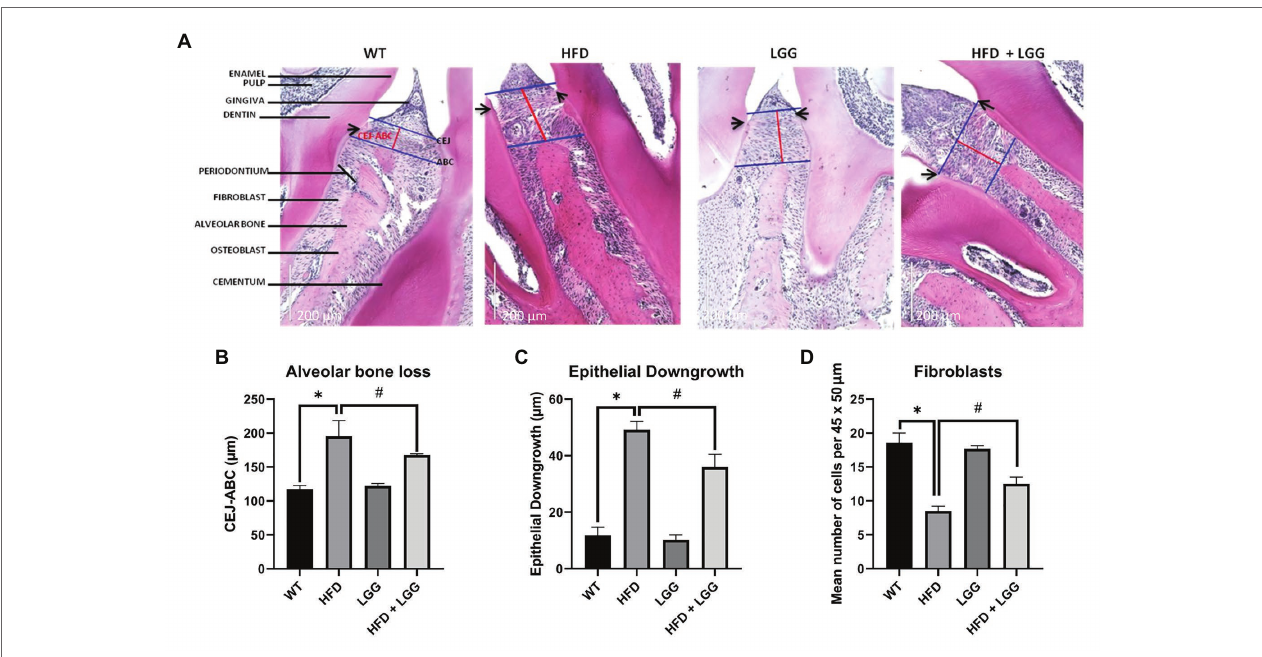
FIGURE 8 | Representative images of hematoxylin-eosin (H&E) staining of periodontal tissue and histomorphometric analysis of alveolar bone loss, ED, and number of fibroblasts per 45 × 50 μ m. WT, Wild-type C57BJ/L6 mice; HFD, HFD-supplemented wild-type mice; LGG, LGG-supplemented wild-type mice; HFD + LGG, HFD, and LGG-supplemented wild-type mice. (A) Representative depiction of histological sections. Images were captured at 20× (200 μ m) magnification after H&E staining. Blue lines represent alveolar bone crest (ABC), and cement enamel junction (CEJ). Red lines represent the alveolar bone loss. Black arrows show the apical extent of the epithelial downgrowth (ED). (B) Alveolar bone-loss was measured as the distance between the CEJ and the ABC. (C) ED was defined by measuring the distance from the cementoenamel junction (CEJ) to the apical extent of the junctional epithelium. Results are expressed in μ m. (D) Bars shows mean number of fibroblasts per 45 × 50 μ m. Scale bars = 200 μ m. All data represent means ± SD, WT vs. HFD group * p < 0.05; HFD vs. HFD + LGG # p < 0.05, n =